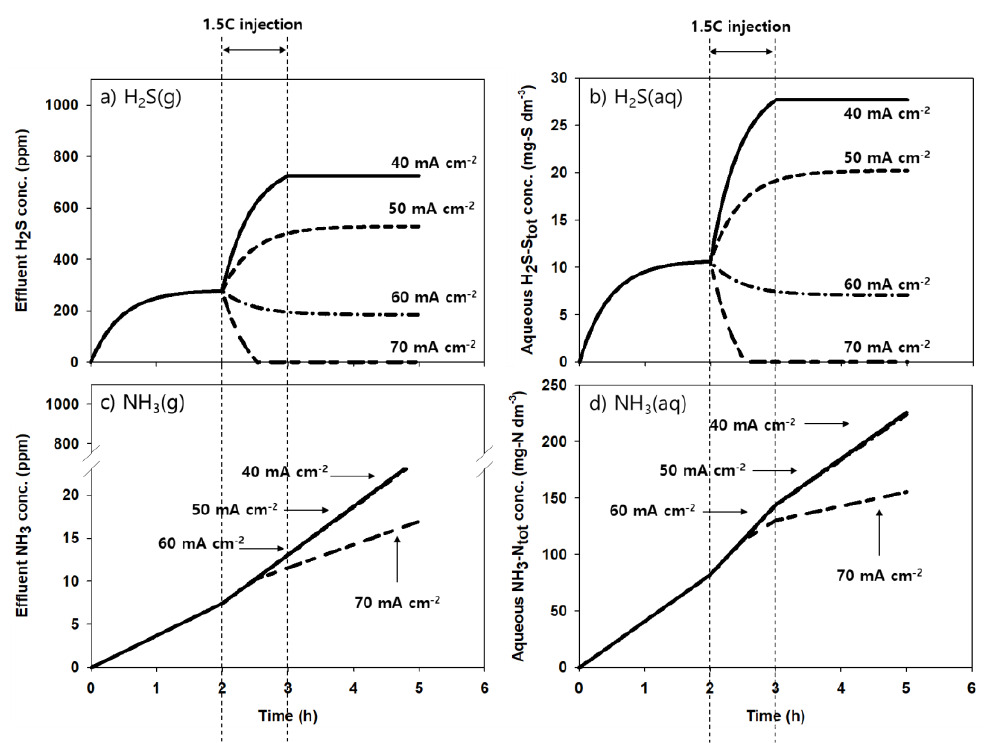
Figure 5. Simulated results of the EWS for a shock loading rate of H 2 S for 6 h: ( a ) effluent H 2 S concentration (ppm), ( b ) aqueous H 2 S concentration in solution (mg-S dm − 3 ), ( c ) effluent NH 3 concentration (ppm), ( d ) aqueous NH 3 concentration in solution (mg-N dm − 3 ) as a function of time.